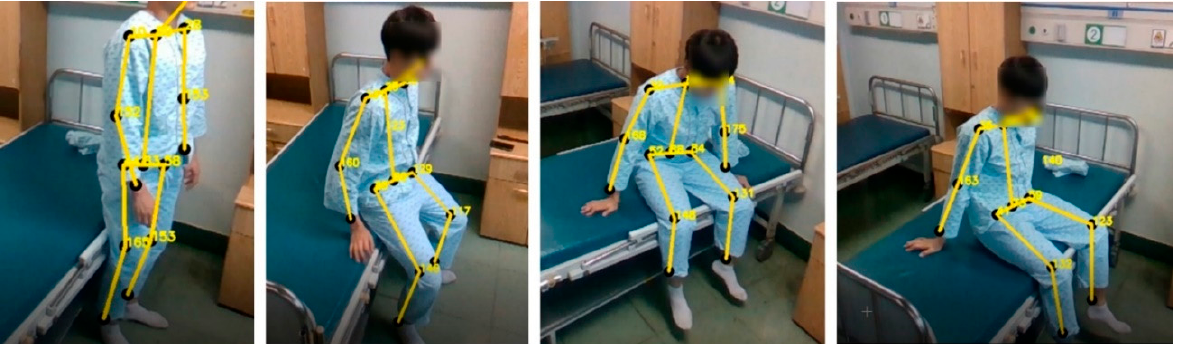
Figure 10. Measurement image of the sitting motion.